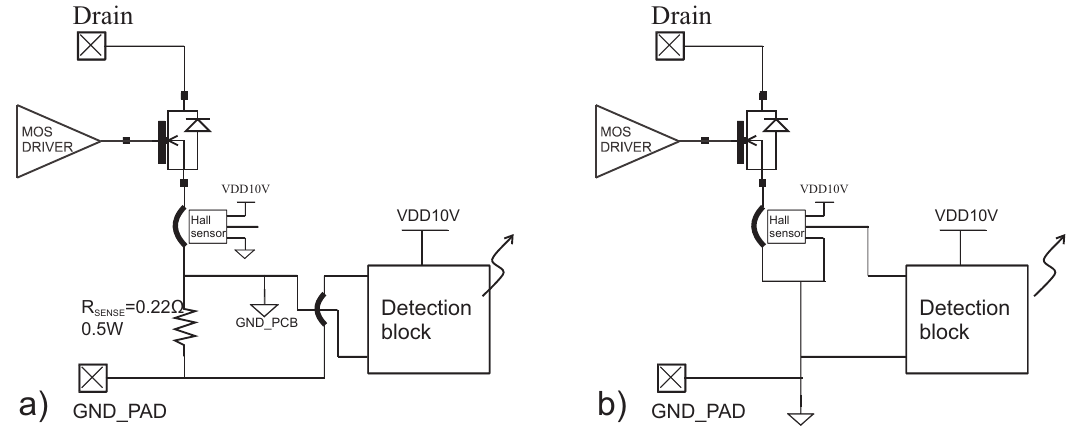
Figure 1. Schematic view of the current sensing setup for: ( a ) resistive approach; and ( b ) the Hall sensor.